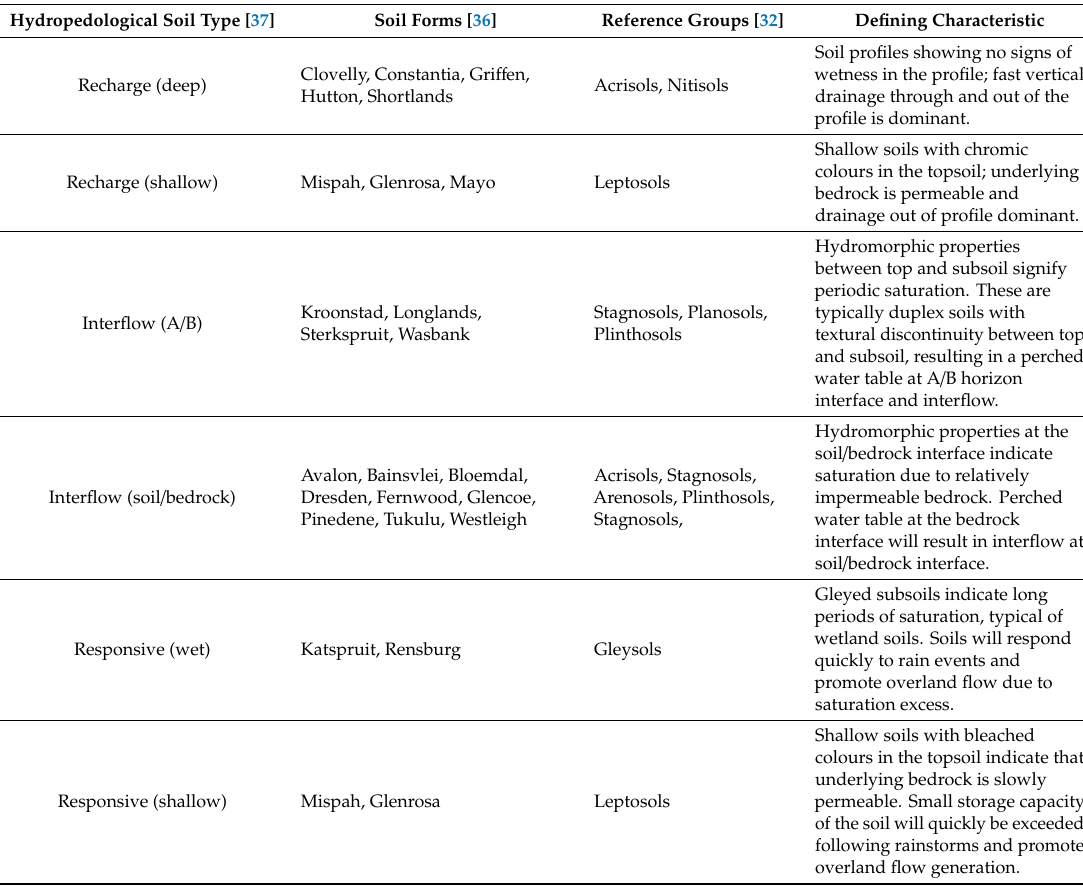
Table 2. Hydropedological soil types used in the DSM data, their dominant characteristics and similar WRB, IUSS reference